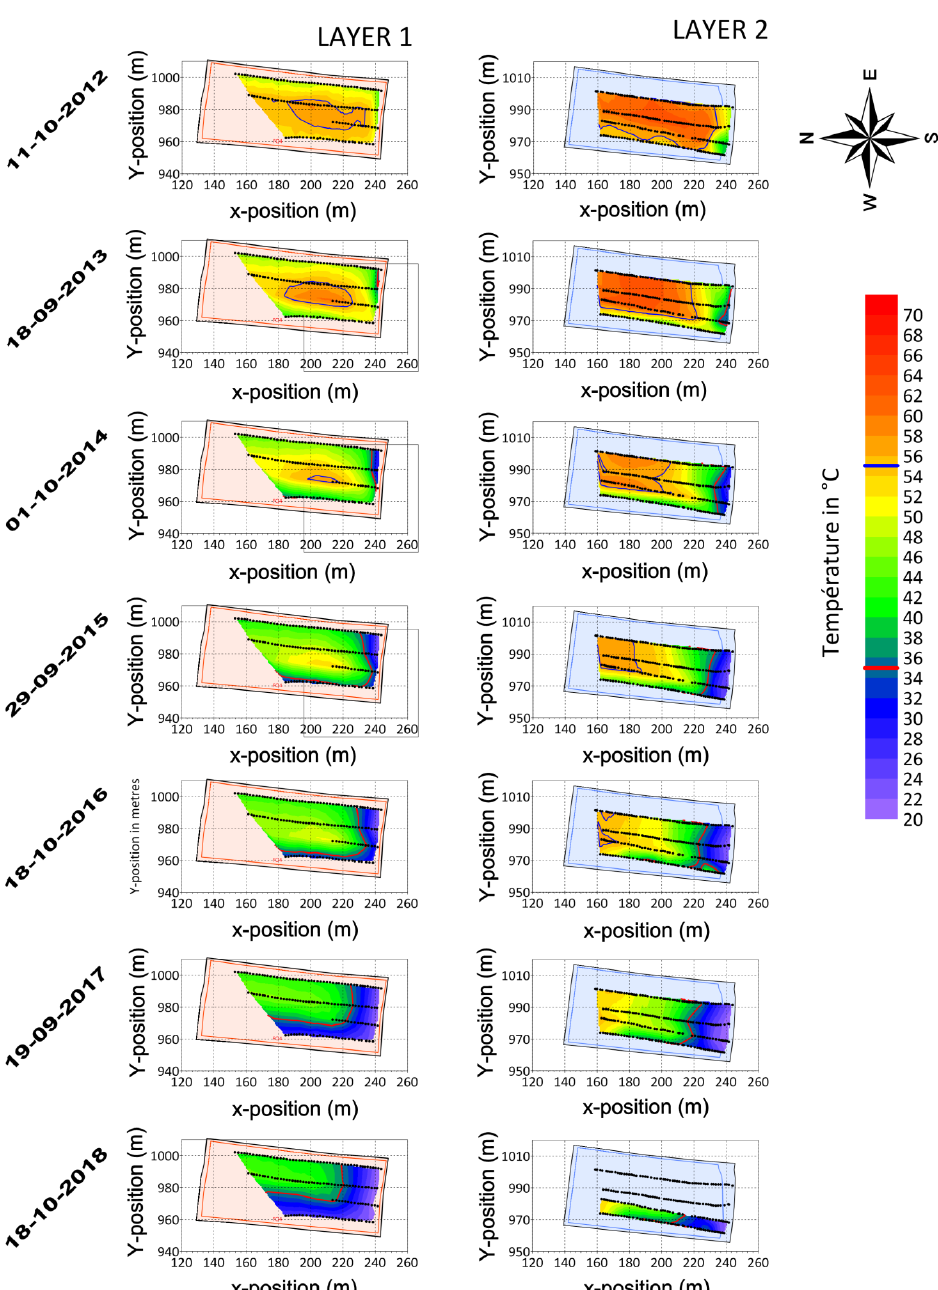
Figure 7. Evolution of interpolated temperature distribution recorded with Distributed Temperature Sensing (DTS) technology in waste CELL4 for Layer 1 and Layer 2.